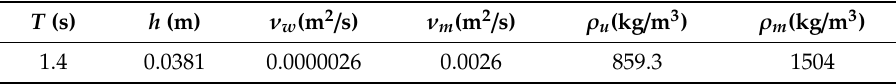
Table 3. Parameters used in the comparative analysis of models